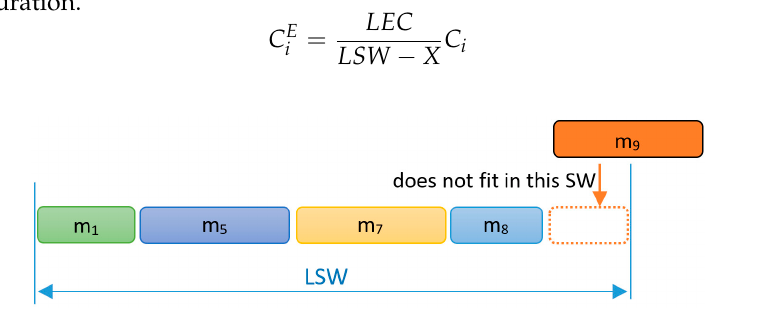
Figure 2. Insert idle time in the Synchronous Window